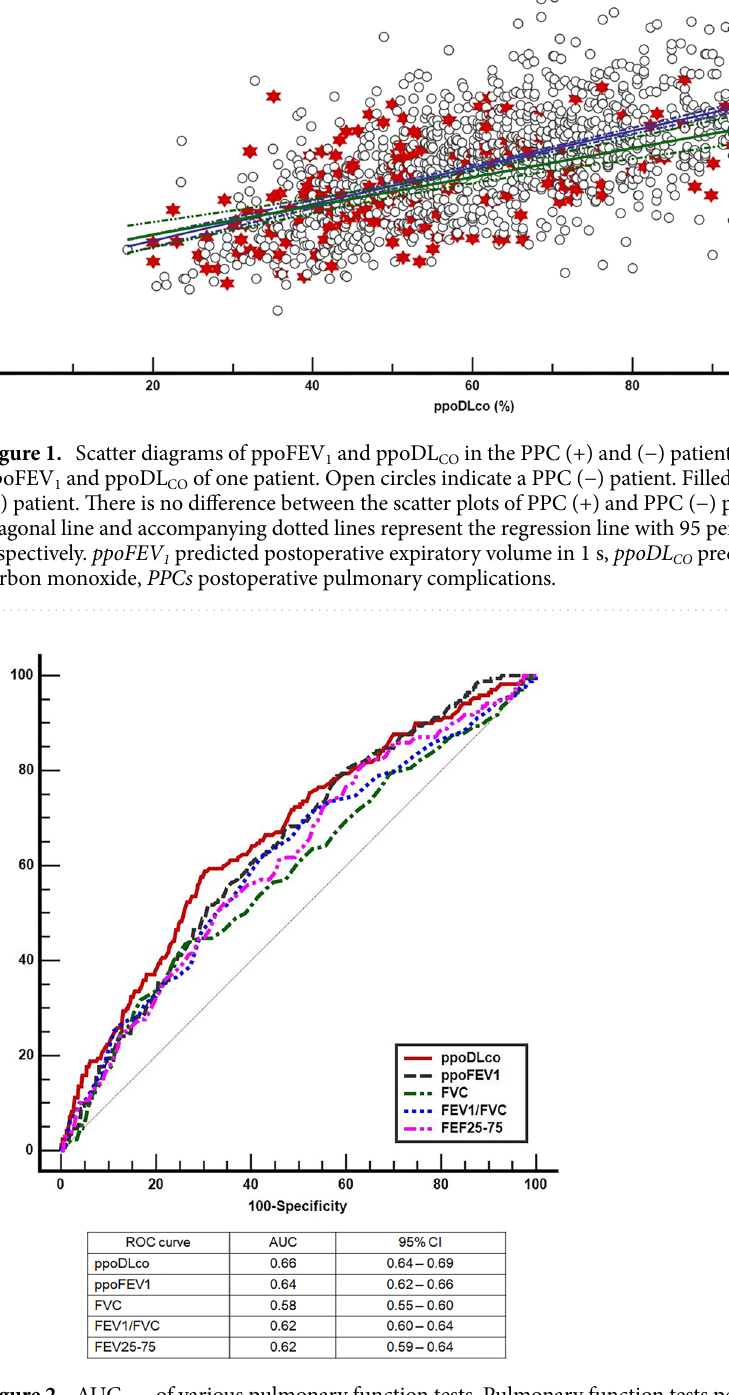
Figure 2. AUC ROC of various pulmonary function tests. Pulmonary function tests performed poorly in predicting postoperative pulmonary complications (AUC ROC : 0.58–0.66). AUC ROC values did not statistically differ from each other, except between ppoDL CO and FVC ( P = 0.010), and between ppoFEV 1 and FVC ( P = 0.005). AUC in forced expiratory flow at 25–75% of the pulmonary volume, FEV 1 /FVC forced expiratory volume in 1 s/forced vital